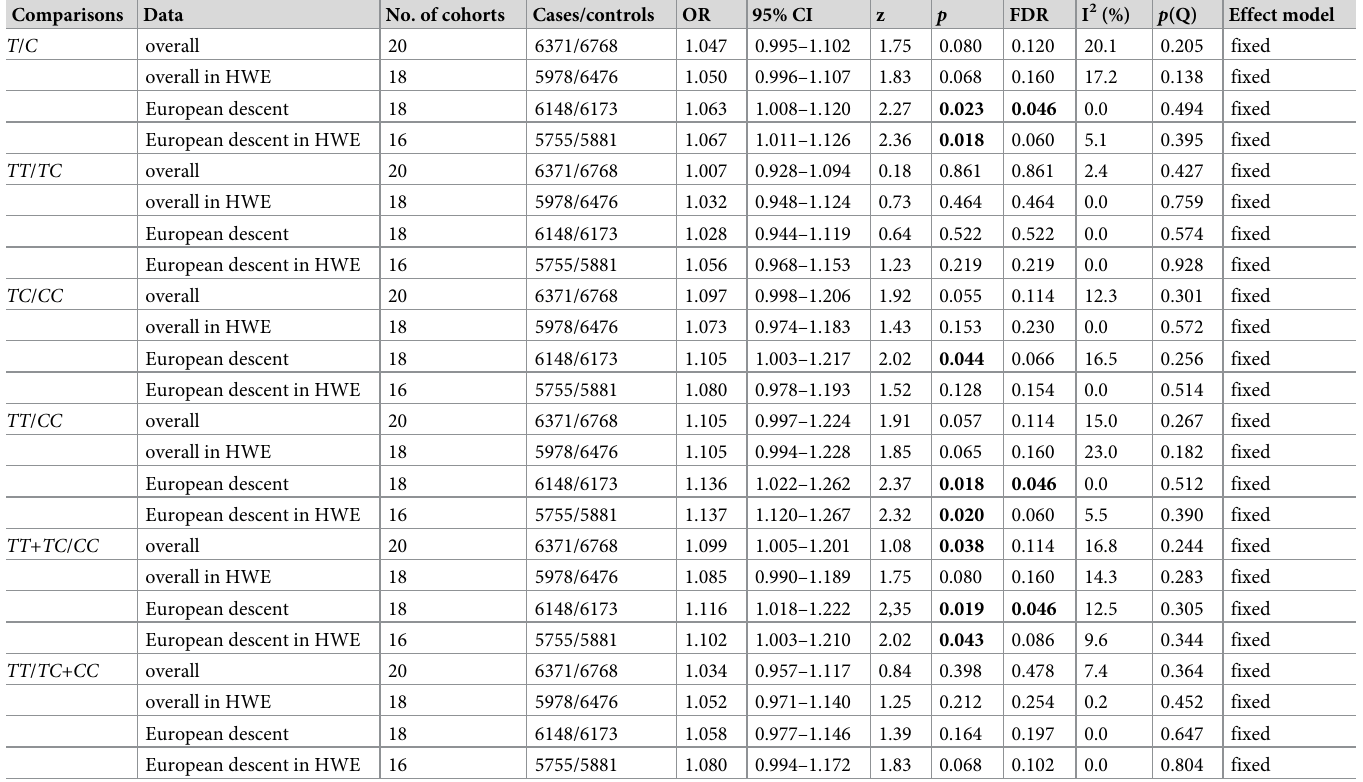
Table 5. Pooled odds ratios for rs1800764 polymorphism and AD susceptibility. Comparisons